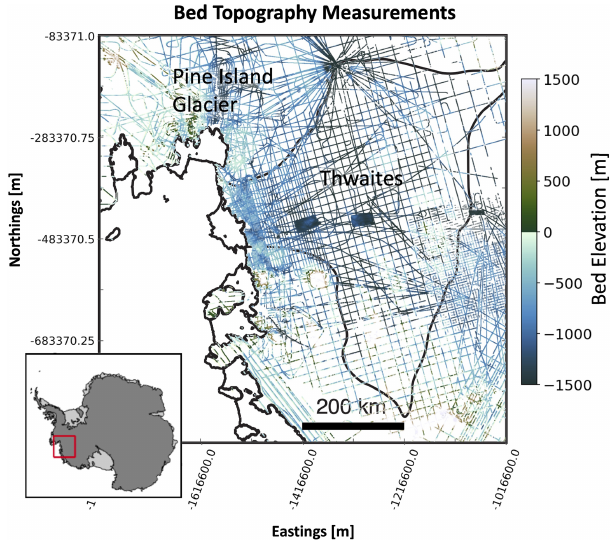
Figure 1. Radar line surveys of the Thwaites and Pine Island glaciers in the Amundsen Sea Embayment of West Antarctica. The red box implies the location of the study area in Antarctica. Black lines indicate boundaries for Thwaites Glacier, ice shelves, and the grounding line (the point where the ice detaches from the bed and achieves flotation). The two topography patches in the centre of Thwaites Glacier were measured using swath radar (Holschuh et al.,